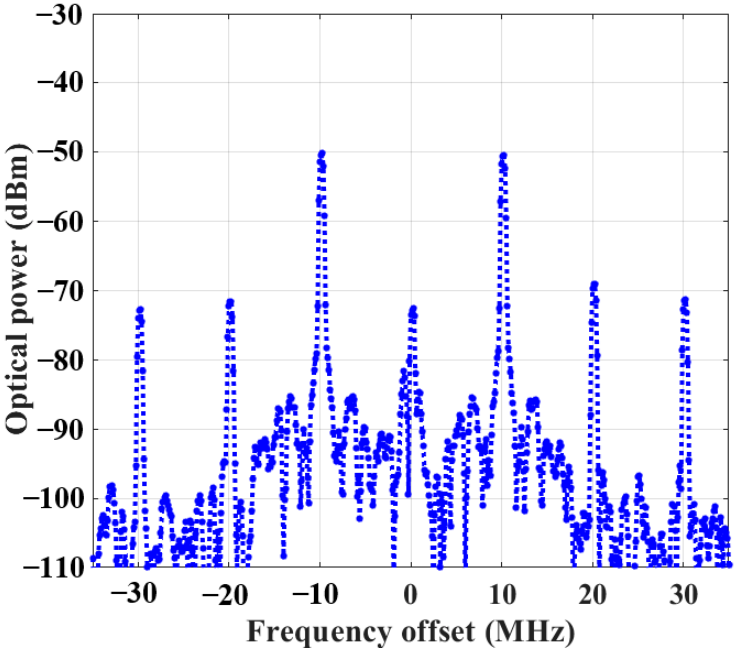
Figure 7. Optical spectrum of the circuit when only MZM b is acting as an intensity modulator. The reference frequency is 193.4125 THz and the resolution bandwidth of the OMA is 477.42 kHz.